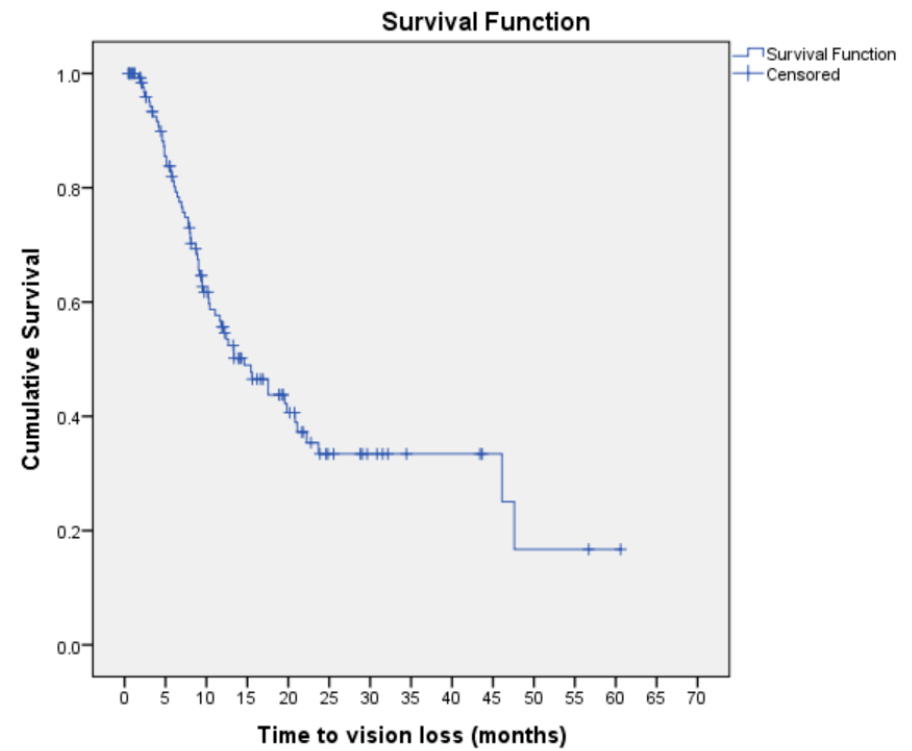
Figure 1. Kaplan–Meier curve for vision loss estimates among subjects with visual improvement post vitrectomy for complications of PDR (n = 134).